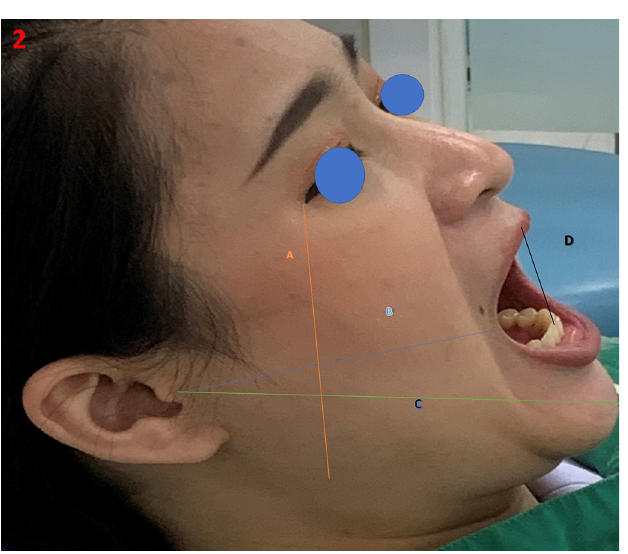
Fig. 3. Facial swelling and trismus measurements. A: Gonion to lateral canthus of eye; B: Tragus to angle of mouth; C: Tragus to pogonion; D: Maximum inter-incisal.